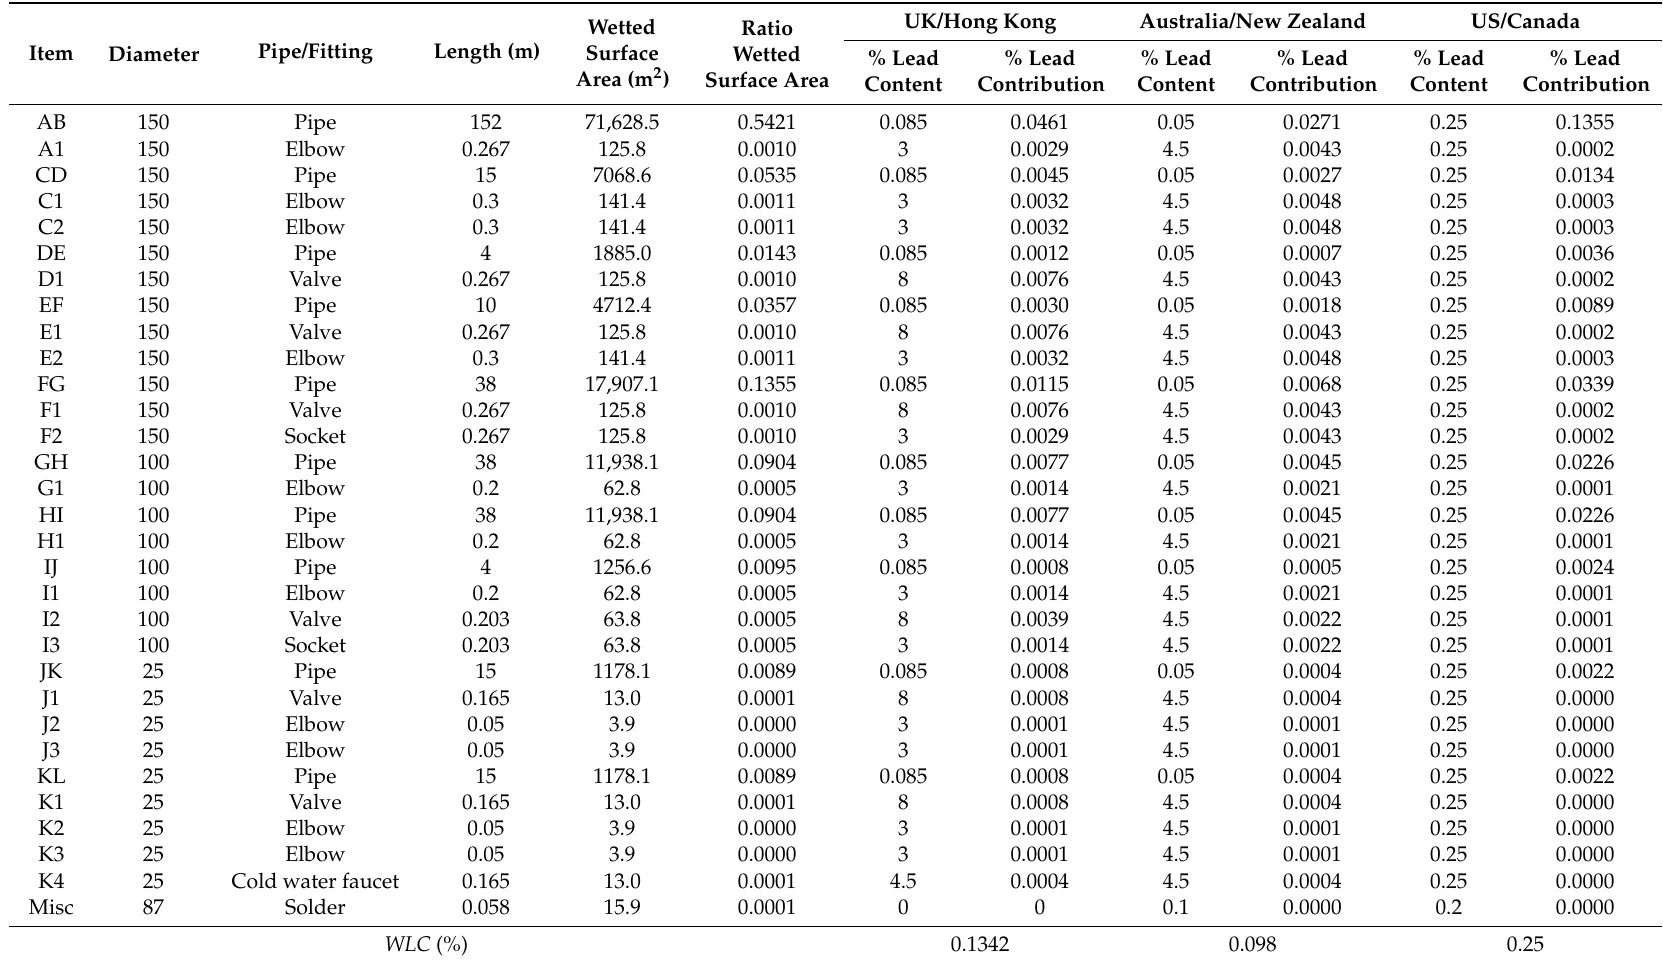
Table 6. Weighted lead content ( WLC )